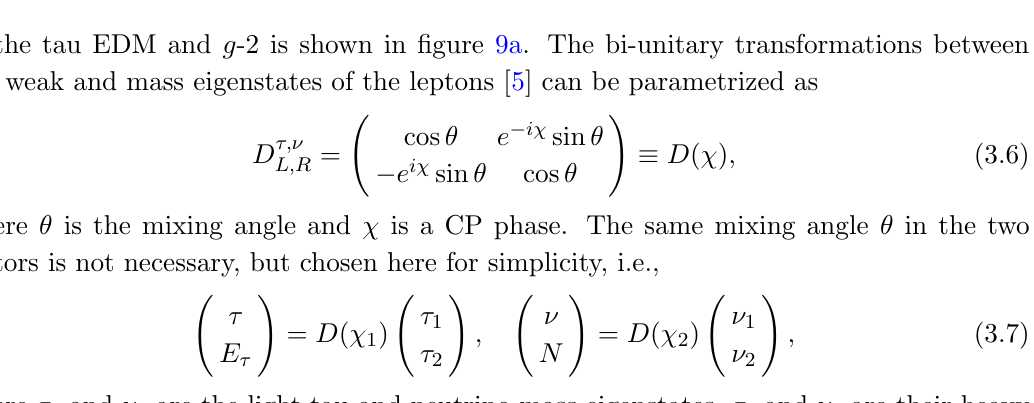
Figure 9 . The Feynman diagram mediated by a heavy mirror neutrino (a), a light scalar (b) and the 2-loop Bar-Zee diagram (c) contributing to the EDM and g